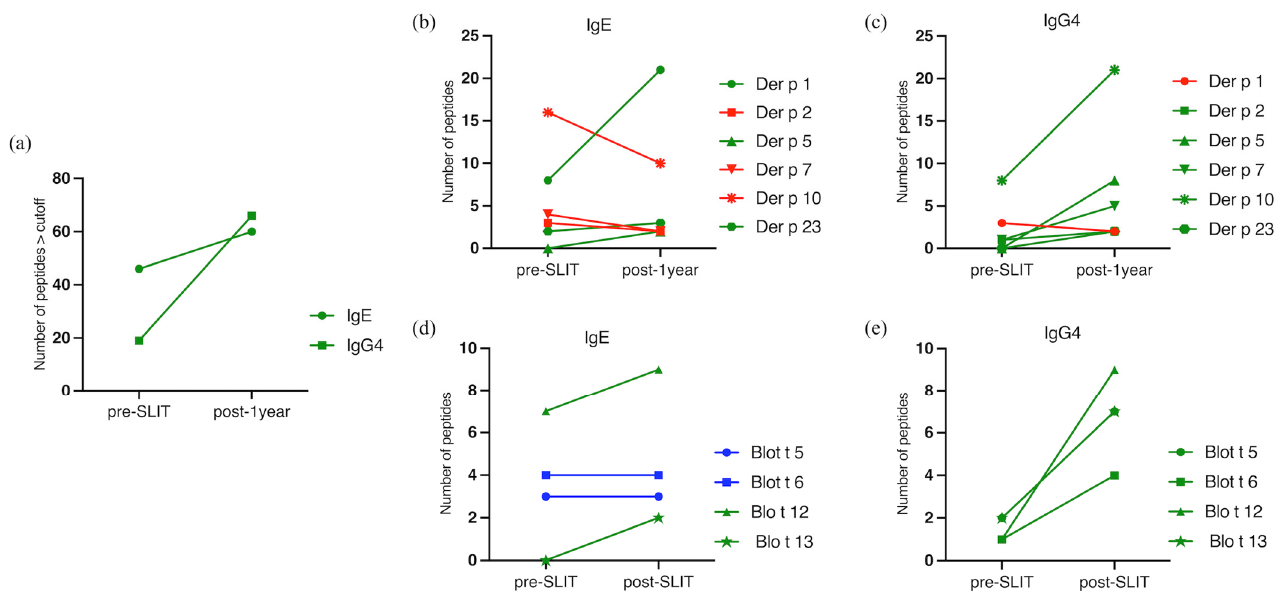
Figure 1. Diversity of peptide reactivity pre- and post-1-year SLIT. ( a ) Diversity of peptides pre- and post-SLIT for IgE and IgG4; ( b ) IgE peptide diversity for Dermatophagoides pteronyssinus molecules; ( c ) IgG4 peptide diversity for Dermatophagoides pteronyssinus molecules; ( d ) IgE peptide diversity for Blomia tropicalis molecules; ( e ) IgG4 peptide diversity for Blomia tropicalis molecules. Green lines indicate an increase of more than 20%, red lines indicate a decrease of at least 20%, blue lines were considered not altered (<20% of alteration).